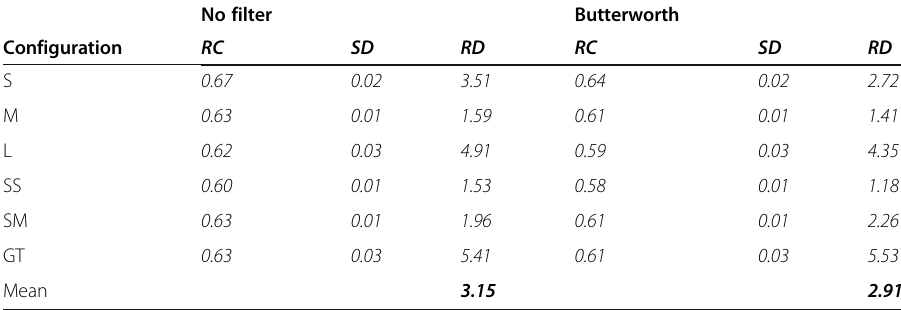
Table 1 Mean recovery coefficient (RC), SD and repeatability (RD), obtained with and without Butterworth post-filtering, derived from the myocardium compartment for various configurations No filter Butterworth